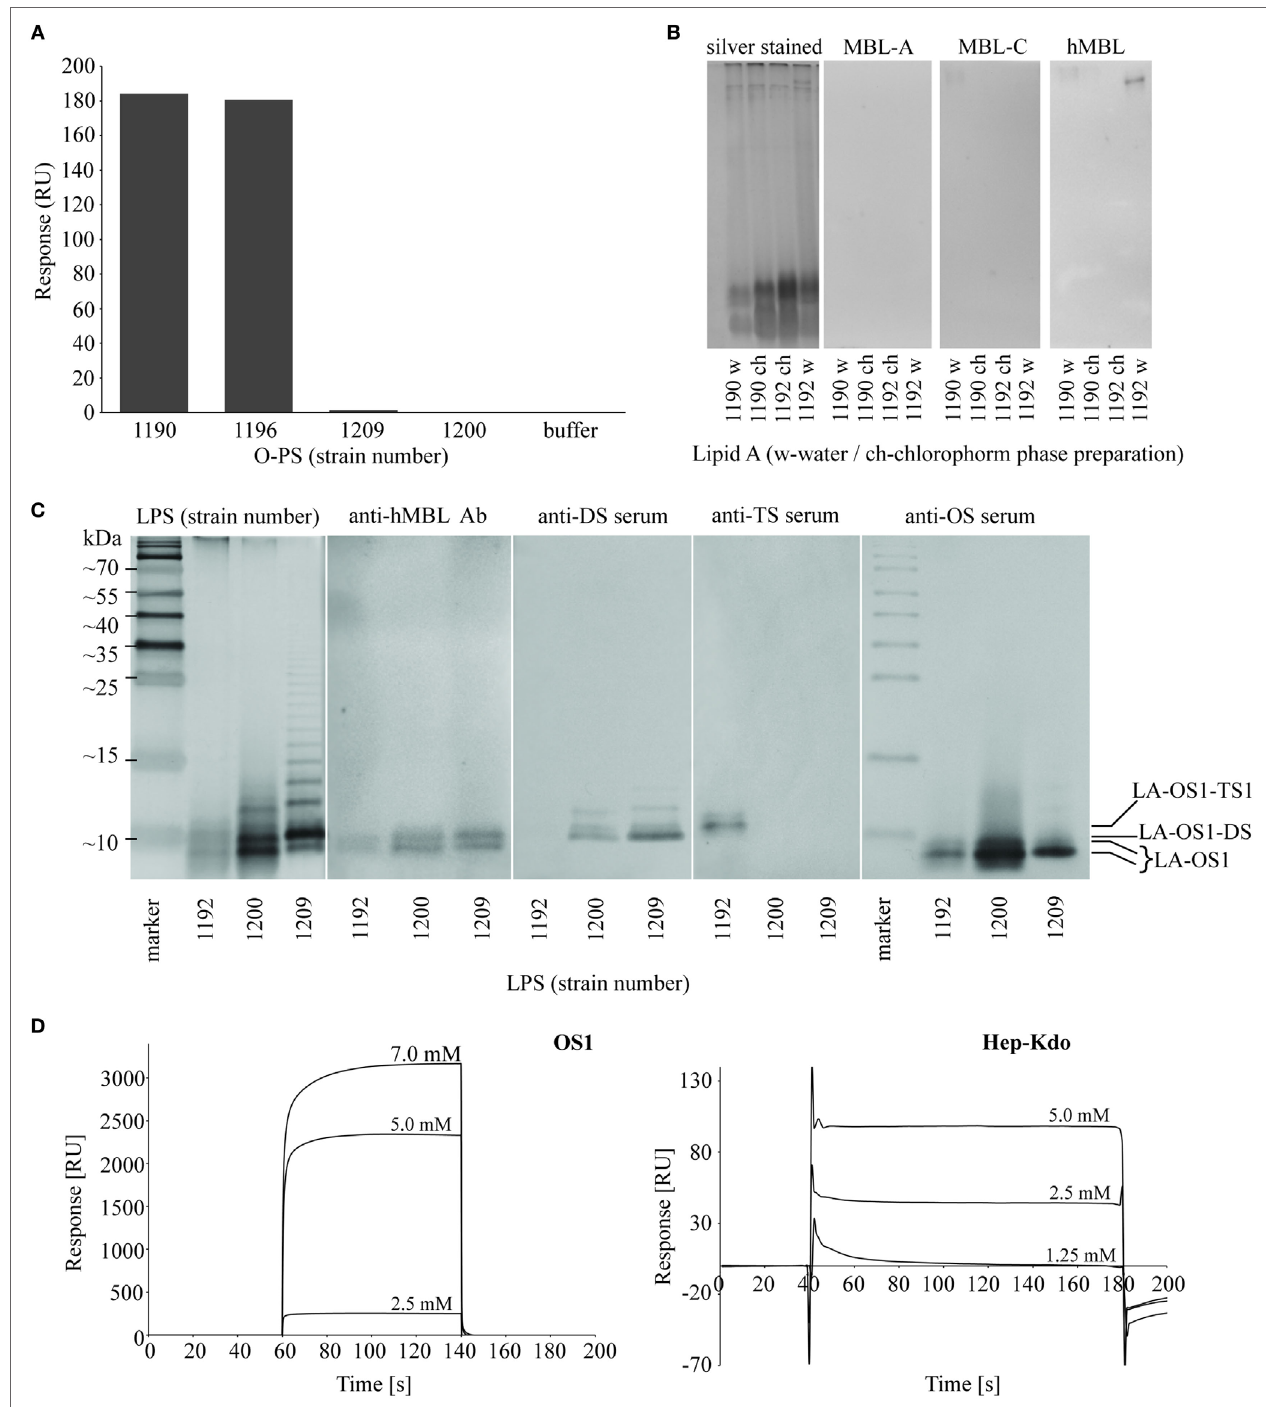
FigUre 5 | Identification of hMBL-binding regions in Hafnia alvei lipopolysaccharides (LPSs) . (a) Surface plasmon resonance (SPR) analysis of interactions between recombinant hMBL and O-specific polysaccharides (O-PSs) of H. alvei PCM 1190, 1196, 1200, and 1209 LPS. The bars represent binding response of immobilized recombinant hMBL (immobilization level: 16,000 RU) to O-PS (0.5 mg/ml) in running buffer HBS-P supplemented with MgCl 2 and CaCl 2 . (B) Silver stained SDS-PAGE and lectin blotting analysis of the interaction between H. alvei lipids A [water phase (w) and chloroform phase (ch) preparations] and serum-derived murine MBL-A, MBL-C, and hMBL. Lanes are depicted with the strain PCM number. (c) Silver stained SDS-PAGE and lectin blotting analyses of the interactions between LPS of H. alvei PCM 1192 (TS1-positive), 1200 (DS-positive), 1209 (DS-positive) and serum-derived hMBL, DS-specific rabbit serum, TS1-specific rabbit serum, and OS1-specific rabbit serum. M—molecular weight markers. Marked bands corresponded to different forms of R-LPS: LA-OS1, LA-OS1-DS, LA-OS1- TS1, where LA stands for lipid A. (D) SPR sensograms for interactions of recombinant hMBL and OS1 and Hep-Kdo-containing OS isolated from H. alvei 1200 LPS. Sensor chip: CM5; Abbreviations: RU, response units; hMBL, human MBL; PCM, Polish Collection of Microorganisms; MBL, mannose-binding lectin.